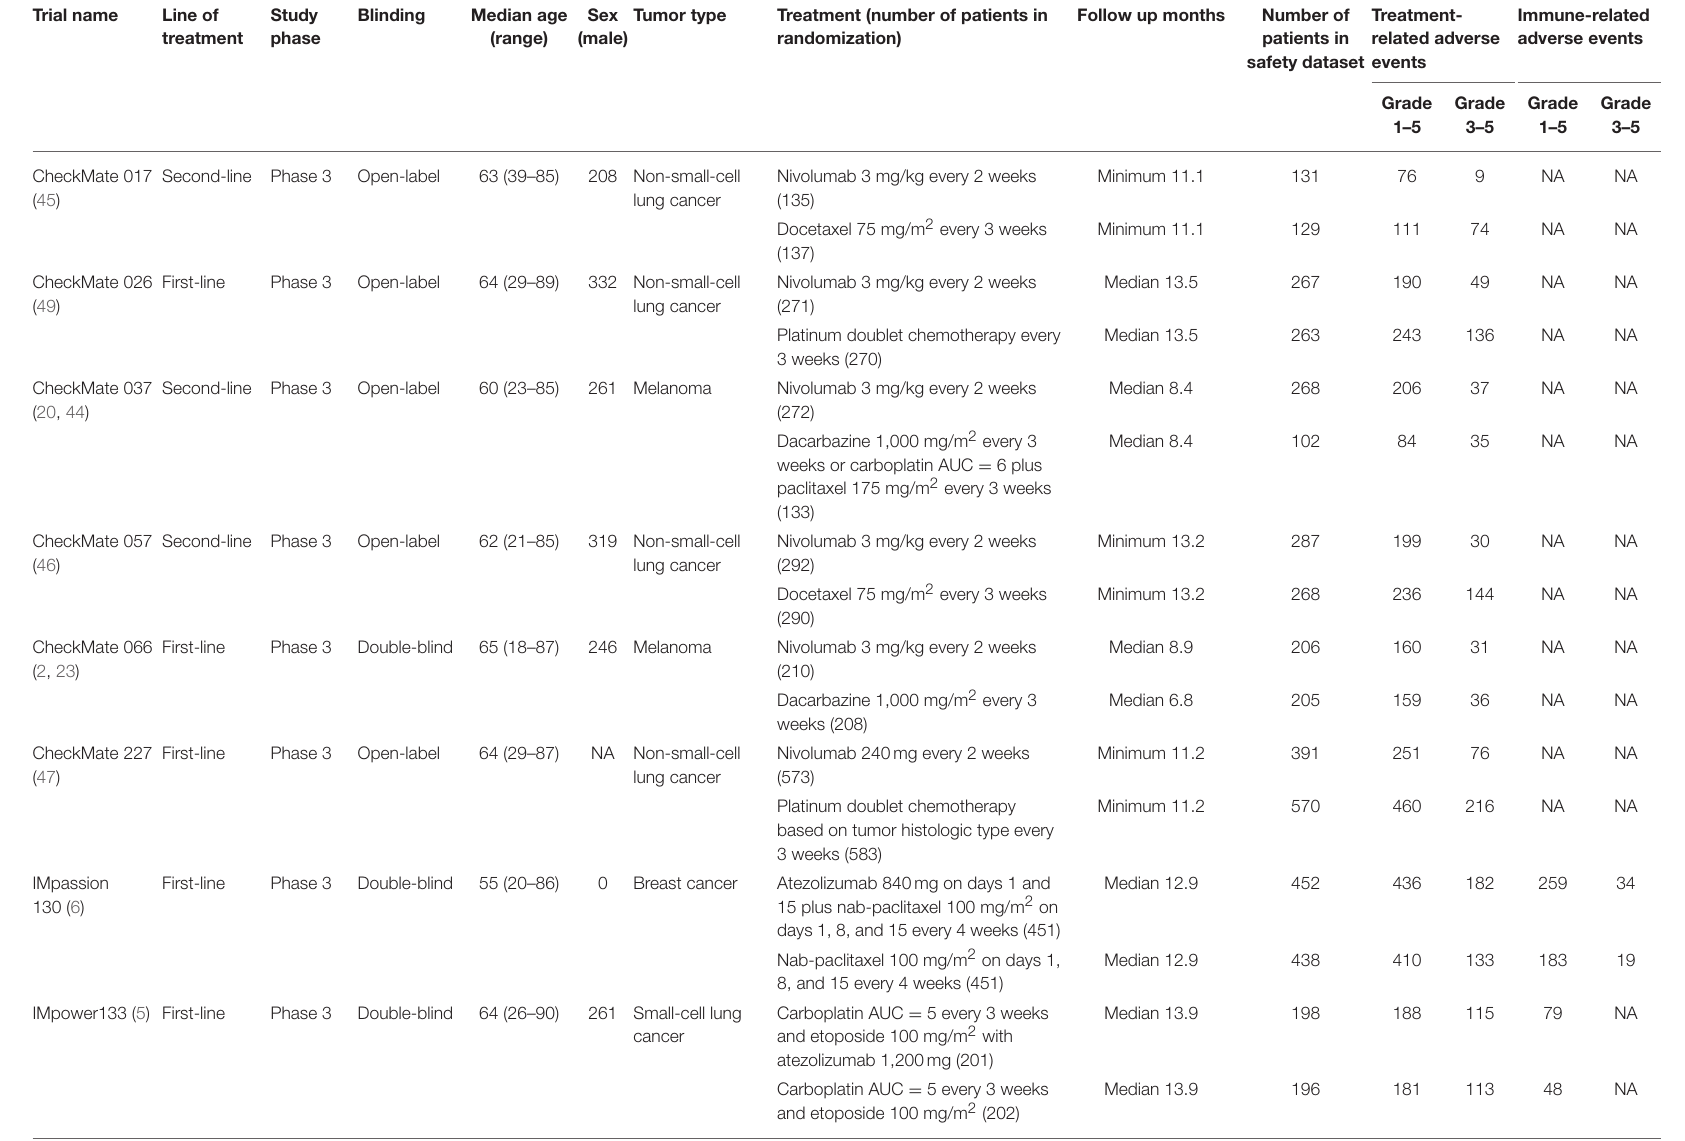
TABLE 1 | Characteristics of included trials (27 articles including 23 randomized controlled